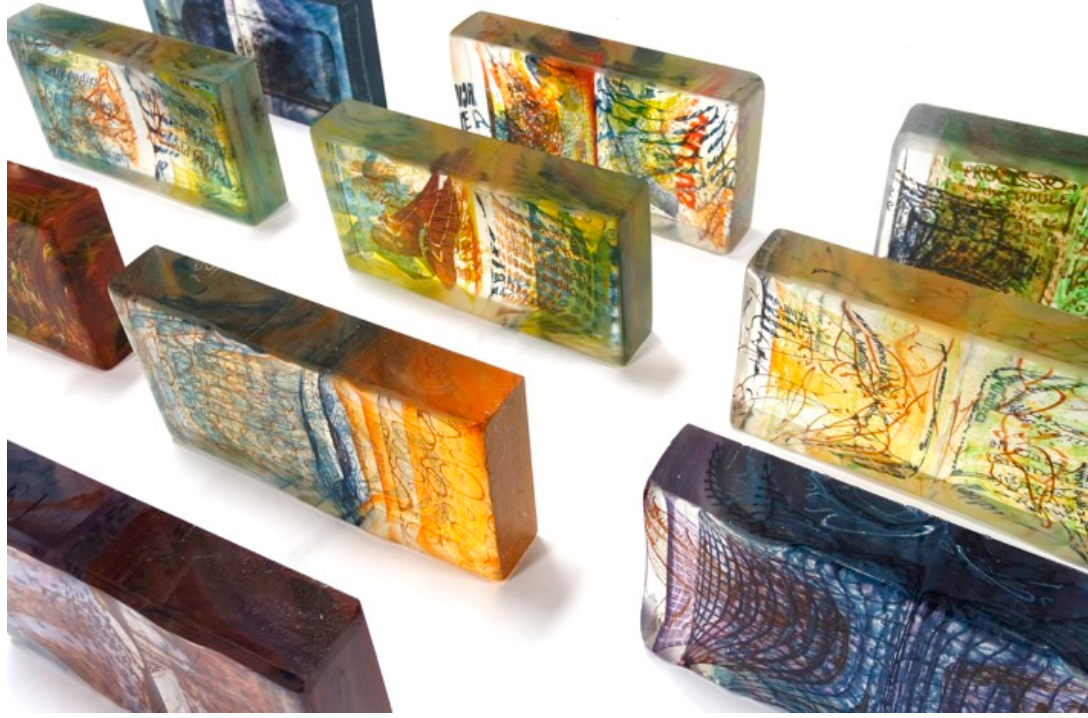
Figure 5. Student work from Graphic Swim workshop. Variations are created through choices in image, color, and layout. Photo: The Author.